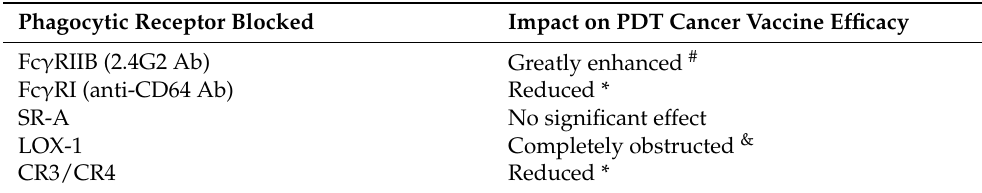
Table 1. The impact of blocking various phagocytic receptors on the efficacy of PDT cancer vaccines. Phagocytic Receptor Blocked